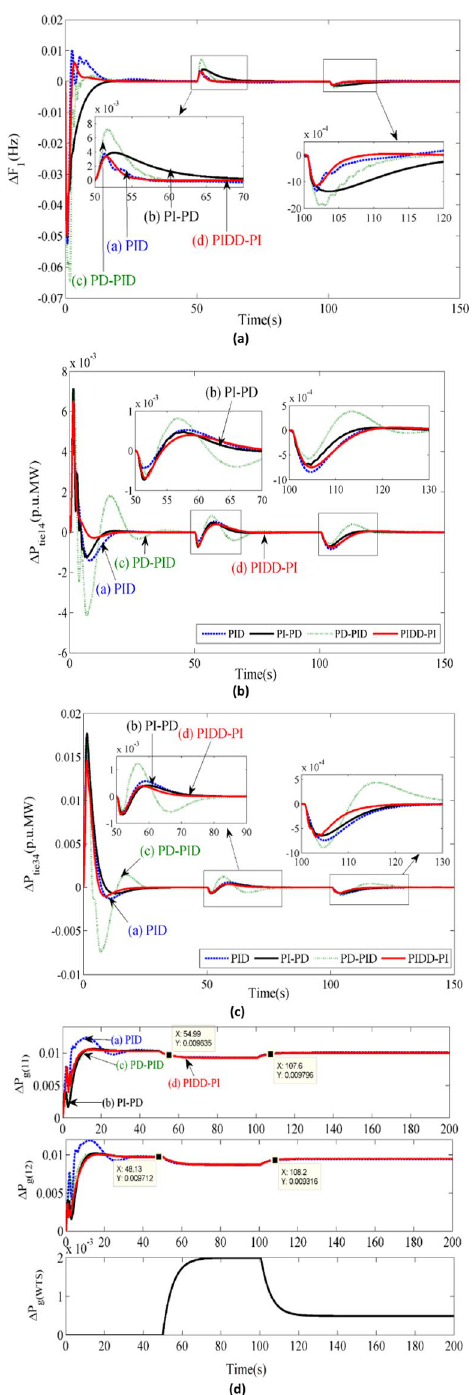
Fig. 3 Comparison of performance of PID, PI-PD, PD-PID and PIDD-PI during bilateral transactions. a Frequency deviation in Area 1. b Tie-power deviation in the line connecting Area 1 and 4. c Tie-power deviation in the line connecting Area 3 and 4. d Power generation in thermal plant and WTG unit in Area